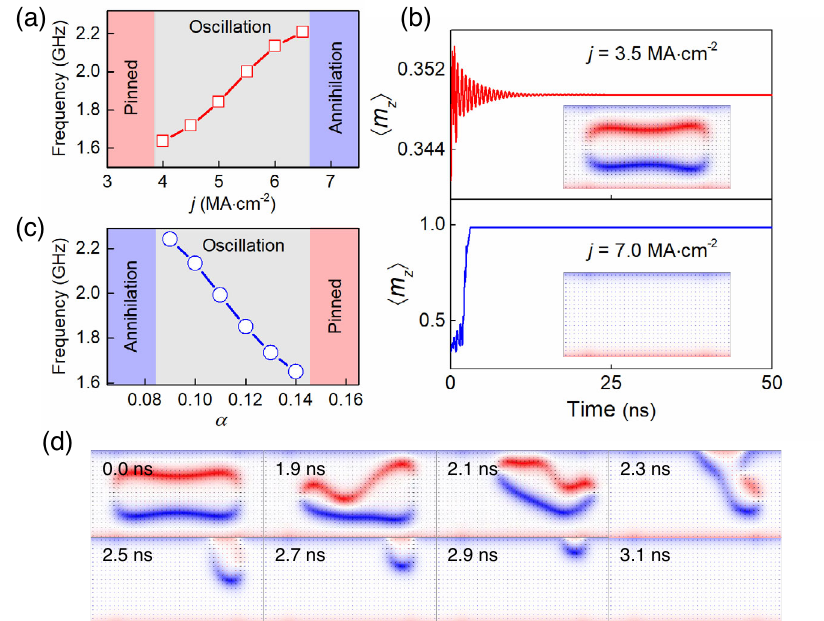
Fig. 4 Effects of the current density and the damping on the oscillation of an elongated skyrmion. a Frequency of the considered oscillation as a function of the driving current density j , where the pink and purple regions denote the pinned phase and annihilation phase, respectively. b Time-dependent of the magnetization 〈 m z 〉 in the cases of pinned and annihilation. Insets are the fi nal stable magnetization con fi gurations. c Oscillation frequency as a function of the damping coef fi cient α . d Snapshots of the dynamical annihilation process of an elongated